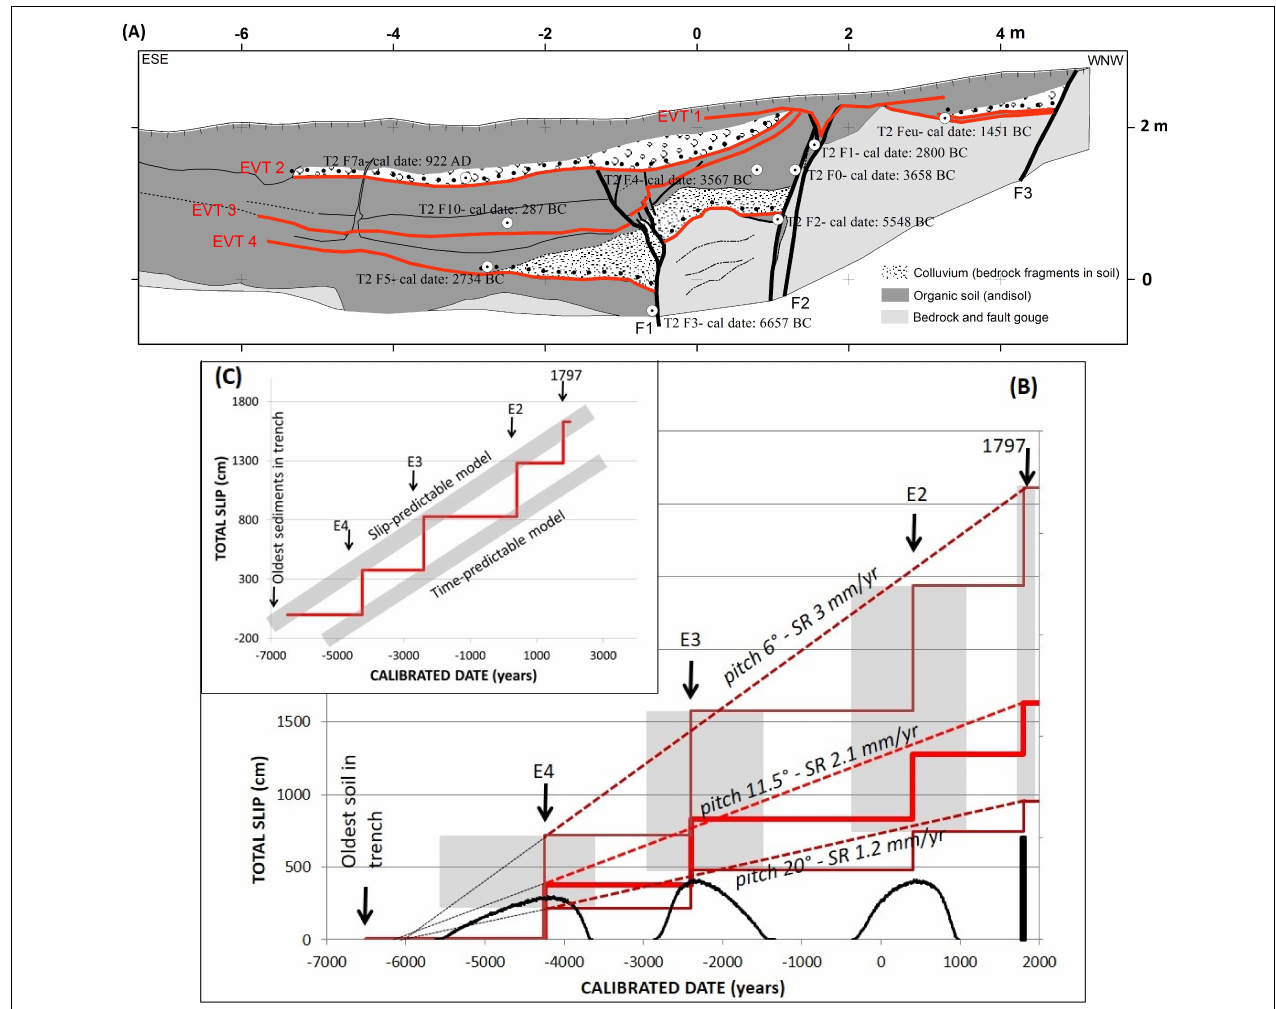
FIGURE 12 | Illustration of the slip versus time history inferred from the Rumipamba trench results. (A) Geological section of trench T2 dug in 2009 in Rumipamba (Baize et al., 2015). We simplified the drawing in representing in a same caption the bedrock fragment-rich horizons (colluvial wedges), the soil units and the bedrock, as well as the fault planes and surrounding shattered rocks. We underline the stratigraphic location of the event horizons that are used in the OxCal analysis. (B) X -axis is calibrated date; black bell-shaped curves are probability density functions of earthquake dates resulting from the stratigraphic model and the resulting Bayesian estimation of dates determined by OxCal online tool. Gray shaded boxes depict the uncertainty ranges of paleoearthquakes including age uncertainty (from OxCal model) and slip range (from possible slip vector range). The staircase curve represents a “mean” slip versus date scenario based on those results, representing three earthquake cycles. A value of paleoseismological slip rate is extracted from this curve, depending on the initial slip vector hypothesis. (C) The “mean” slip versus data scenario (staircase curve) is presented to illustrate that the Rumipamba better matches a slip-predictable